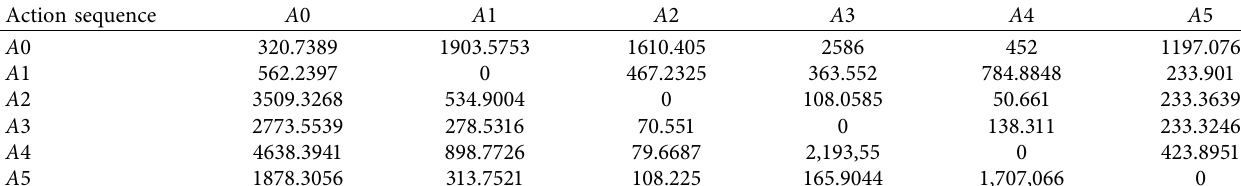
Table 6: Action sequence segmentation.